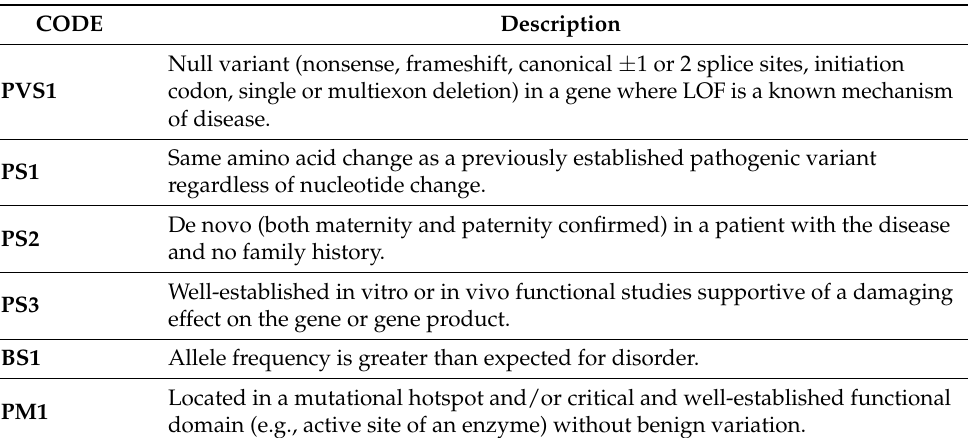
Table A1. American College of Medical Genetics and Genomics